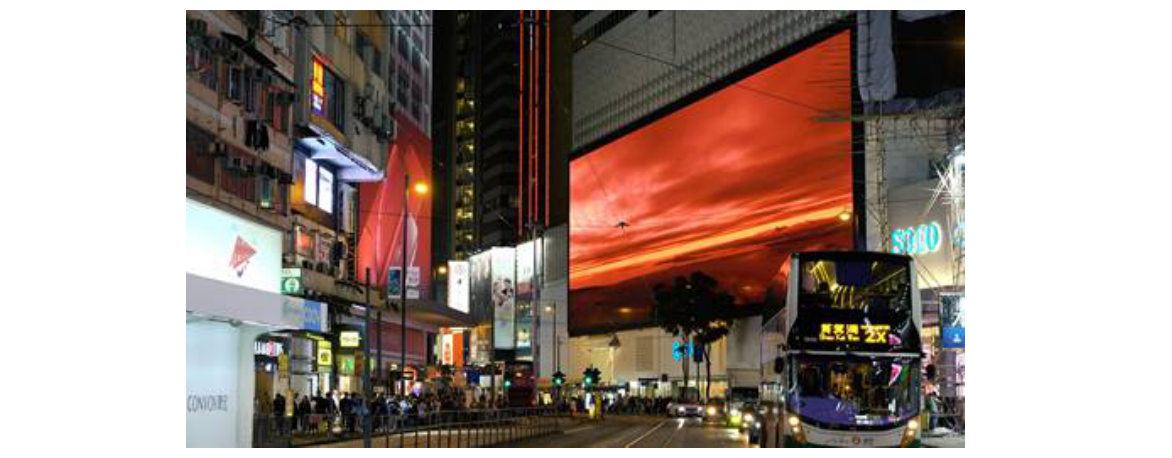
Figure 1 Embers , Hong Kong, China (Source: Videotage,